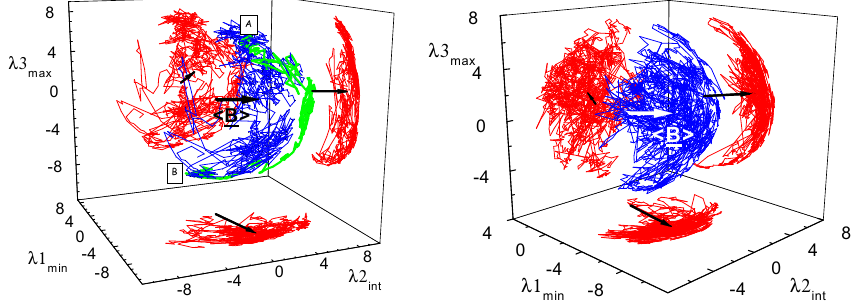
Figure 98: Trajectory followed by the tip of the magnetic field vector (blue color line) in the minimum variance reference system for interval #1 (left) and #2 (right). Projections on the three planes (red color lines) formed by the three eigenvectors 𝜆 1 , 𝜆 2 , 𝜆 3 , and the average magnetic field vector, with its projections on the same planes, are also shown. The green line extending from label A to label B refers to the arc- like discontinuity shown in Figure 97. The time resolution of the magnetic field averages is 6 s. Image reproduced by permission from Bruno et al. (2001), copyright by Elsevier. (To see animations relative to similar time intervals click on Figures 99 for a timeseries affected by the intermittency phenomenon or at 100 for non-intermittent and intermittent